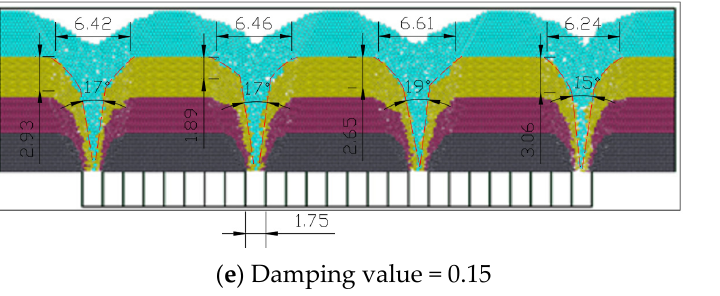
Figure 5. Rules of the coal-rock interface of Level 1 under different damping values (The unit in the picture is meter).